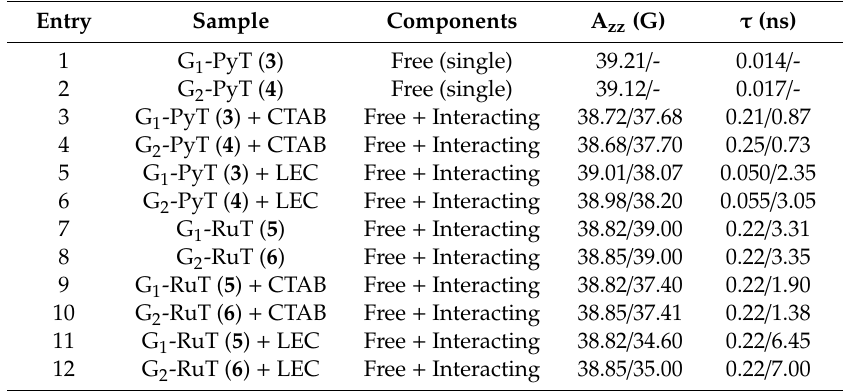
Table 1. Main parameters of computation for the labelled dendrimers G n -PyT and G n -RuT in the absence and presence of model